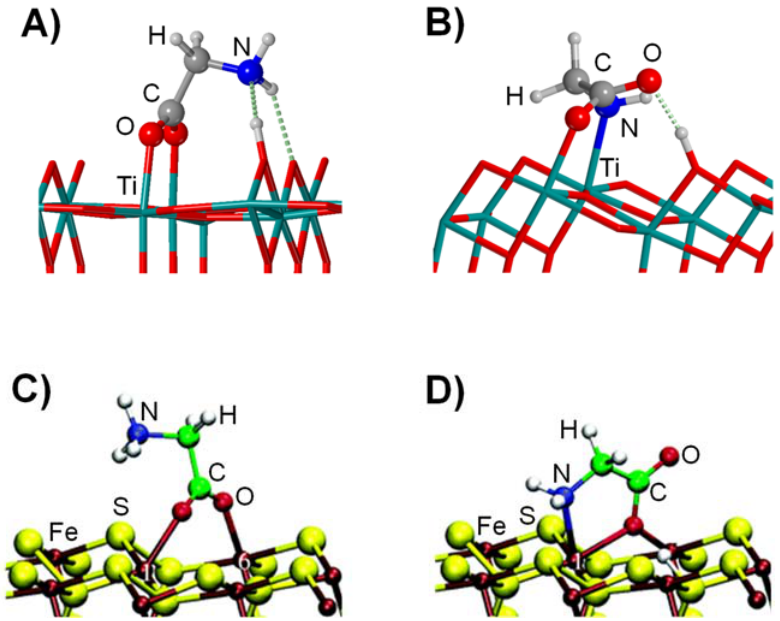
Figure 6. Interaction of Gly with the rutile (110) and the anatase (101) TiO 2 surfaces ( A ) and ( B ), respectively, adapted from Refs. [180,179]), and with a vacancy ‐ defective (100) FeS 2 surface ( C ) and adapted from Refs. [179,180]), and with a vacancy-defective (100) FeS 2 surface ( C , D ), adapted from ( D ), adapted from Ref. [181]). Ref.